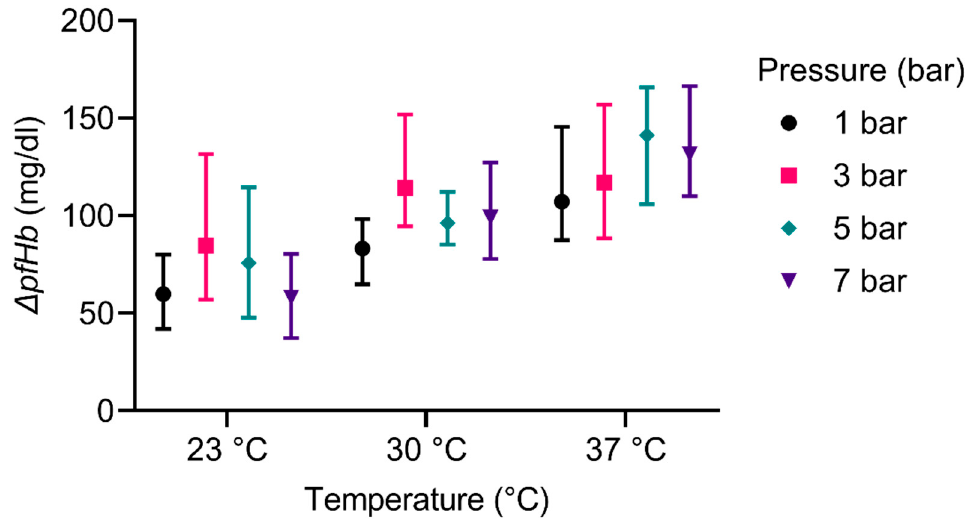
Figure 6. Plasma free hemoglobin dependent on temperature and pressure. The whiskers represent the highest and lowest values of the corresponding experiments.